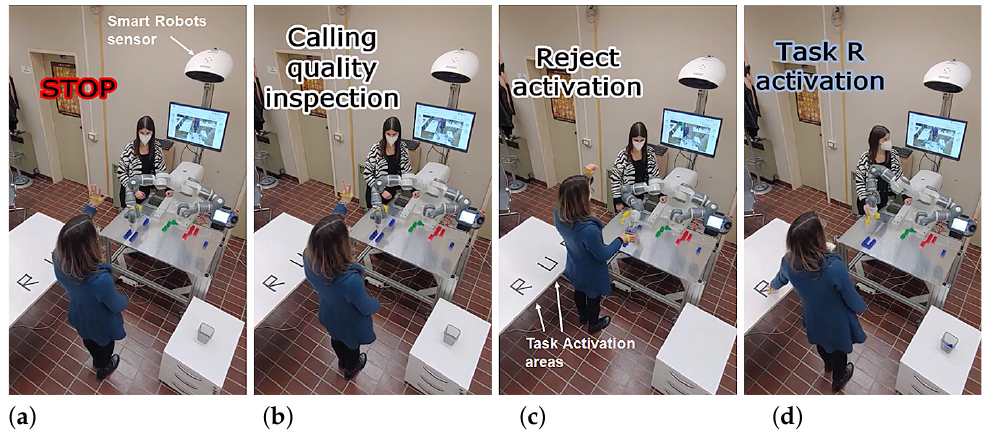
Figure 4. ( a – d ): example of gesture recognition phases using Smart Robots on YuMi